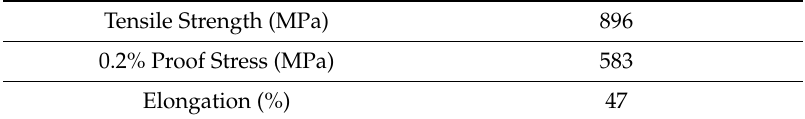
Table 1. Mechanical properties of work material.